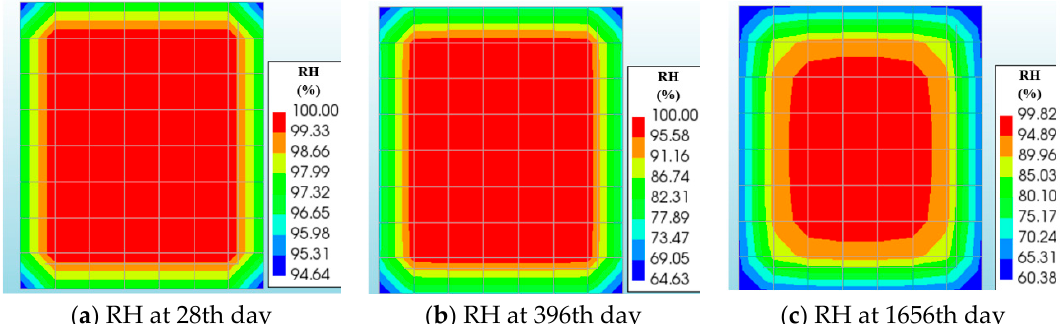
Figure 5. Relative humidity (RH) distribution along the section of the short-span PSC beam.